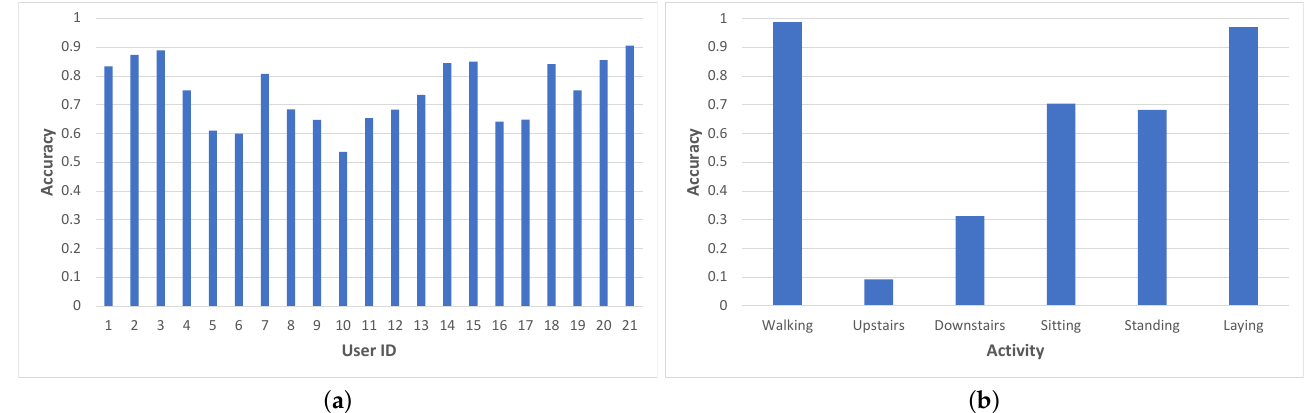
Figure 13. Accuracy of the classification for the user study. ( a ) Per user. ( b ) Per activity.